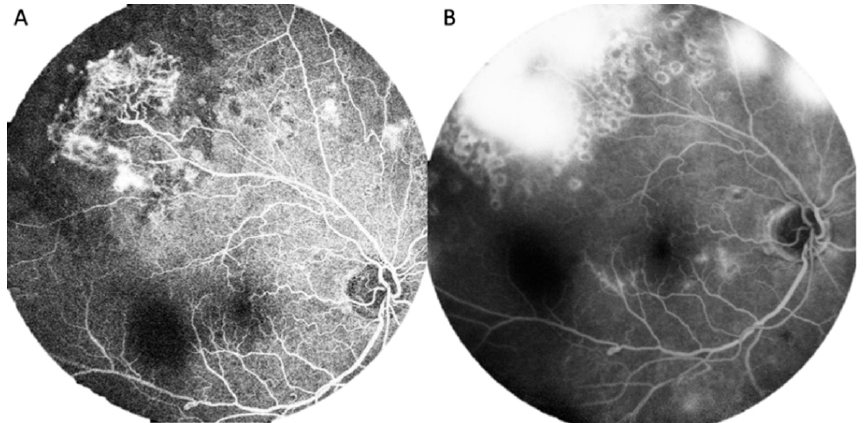
Figure 2. ( A ) Fluorescence stains with surrounding non-perfusion area due to laser treatment at temporal upper and some neovascular lesion on the peripapillary area in the right eye; and ( B ) Diffuse fluorescence leakage at late stage in the right eye.